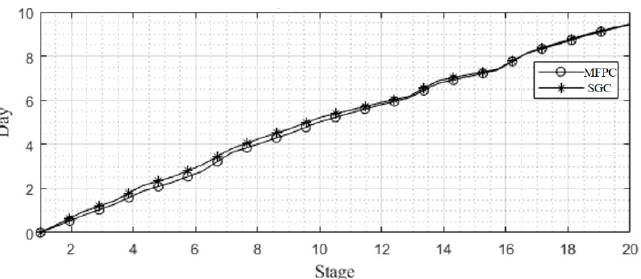
Figure 11. Estimated time arrival (modified fixed power control vs. speed governor control).